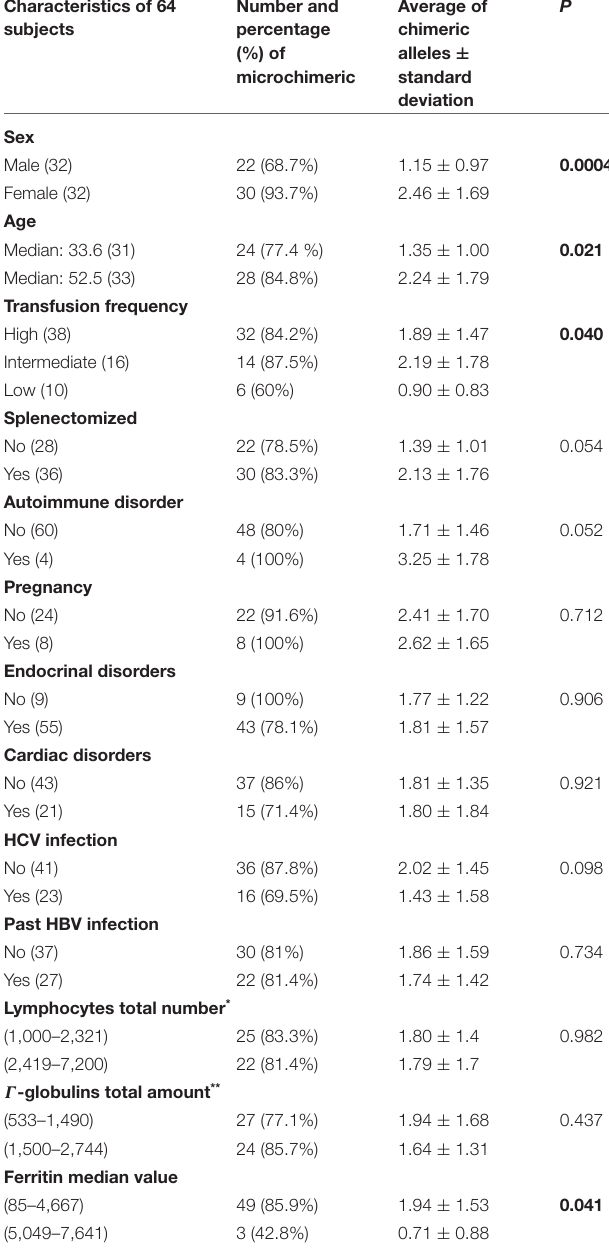
TABLE 4 | Patient demographics and main clinical and laboratory characteristics associated with TA-MC status. Characteristics of 64